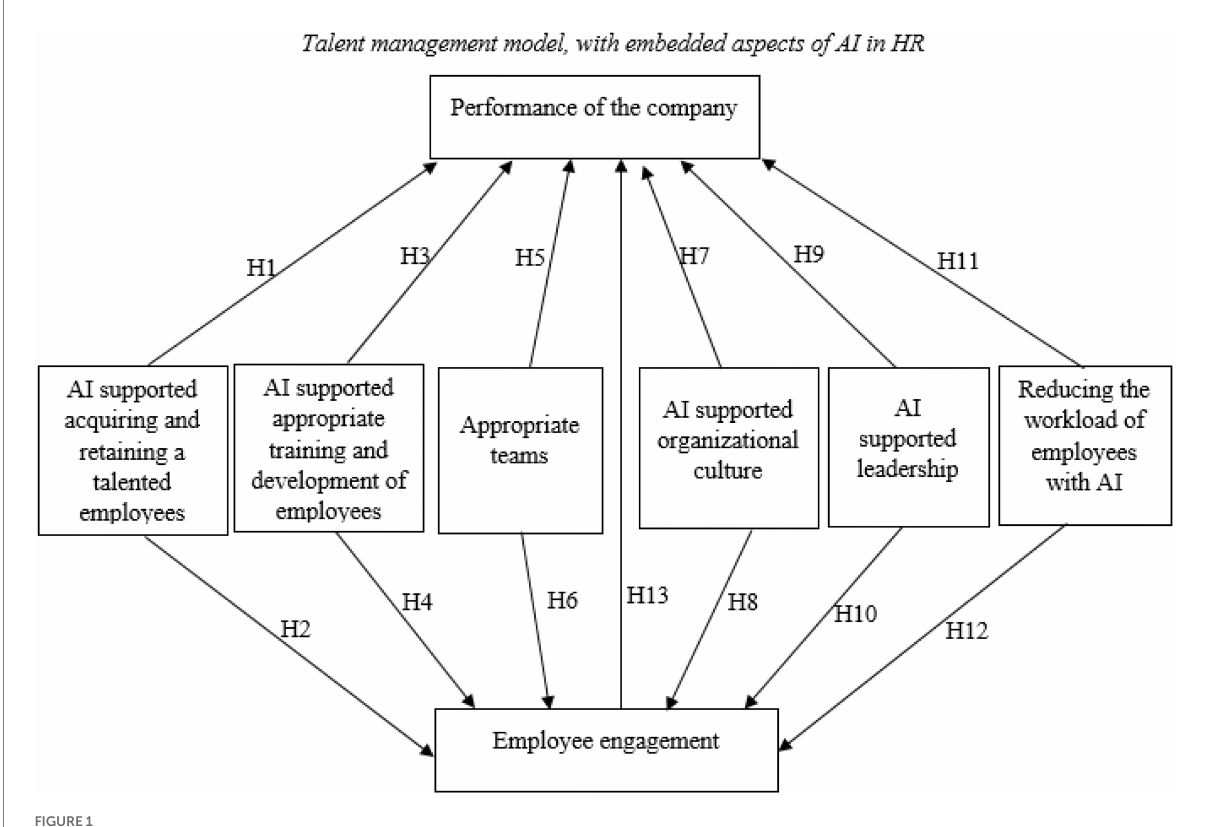
FIGURE 1 Conceptual model and